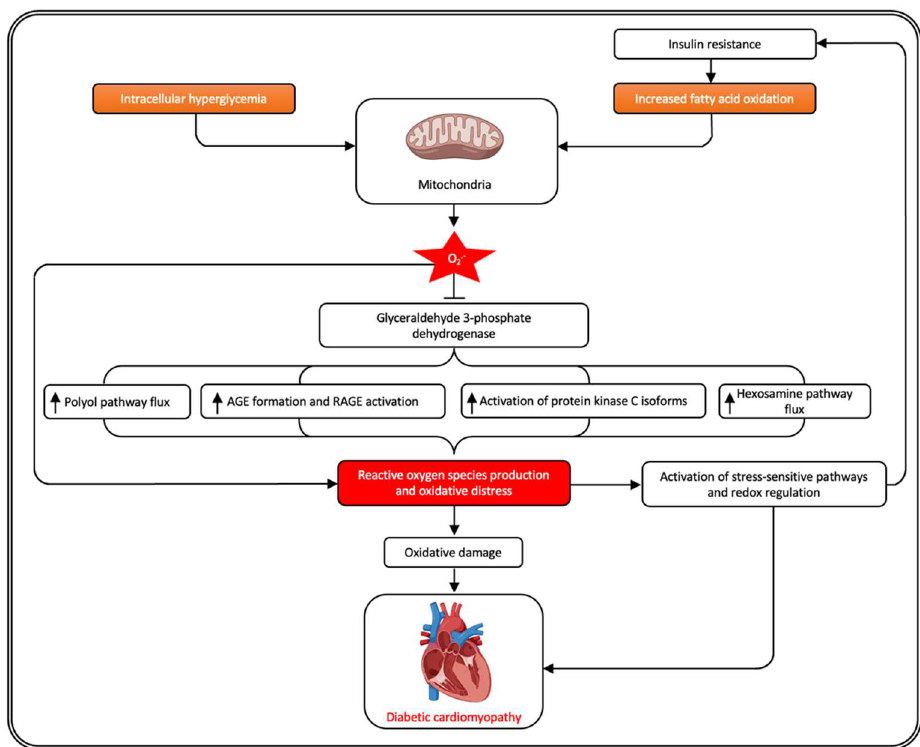
Figure 1. Central role of reactive oxygen species and oxidative distress in the development of diabetic cardiomyopathy. Mitochondrial overproduction of superoxide anion radicals induces, via inhibition of glyceraldehyde 3-phosphate dehydrogenase, an increased polyol pathway flux, increased advanced glycation end-products (AGE) formation and activation of the receptor for AGE (RAGE), activation of protein kinase C isoforms, and an increased hexosamine pathway flux. These pathways not only directly contribute to diabetic cardiomyopathy (arrows not shown) but are themselves a source of additional reactive oxygen species and oxidative distress. Oxidative distress itself is also a cause of insulin